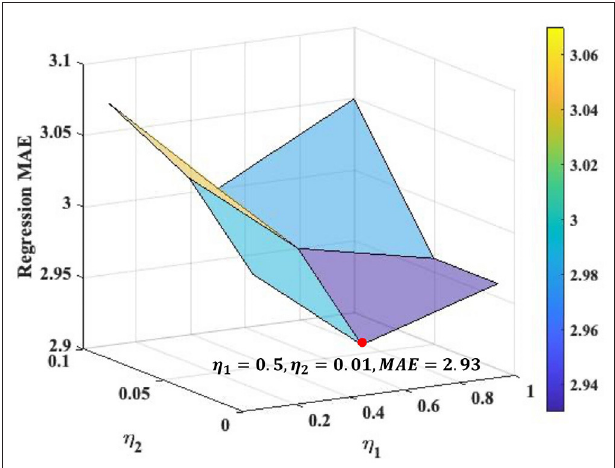
FIGURE 2 | Loss weights analysis for the Overall ASR regression task. The optimal values of η 1 and η 2 are 0.5 and 0.01, respectively, where the MAE of overall regression achieves as